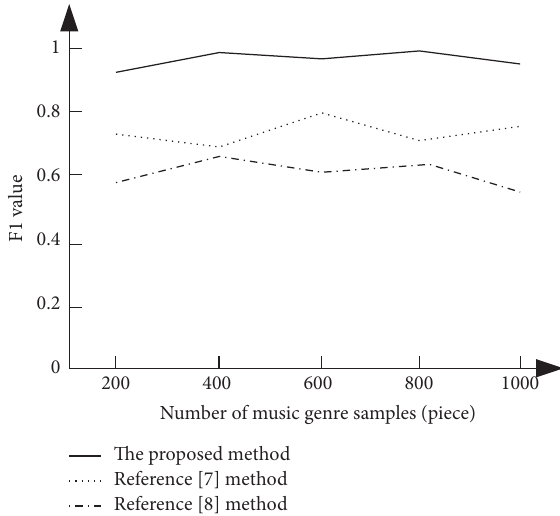
Figure 9: Comparison results of F1 values of automatic classifi- cation of music genres by different